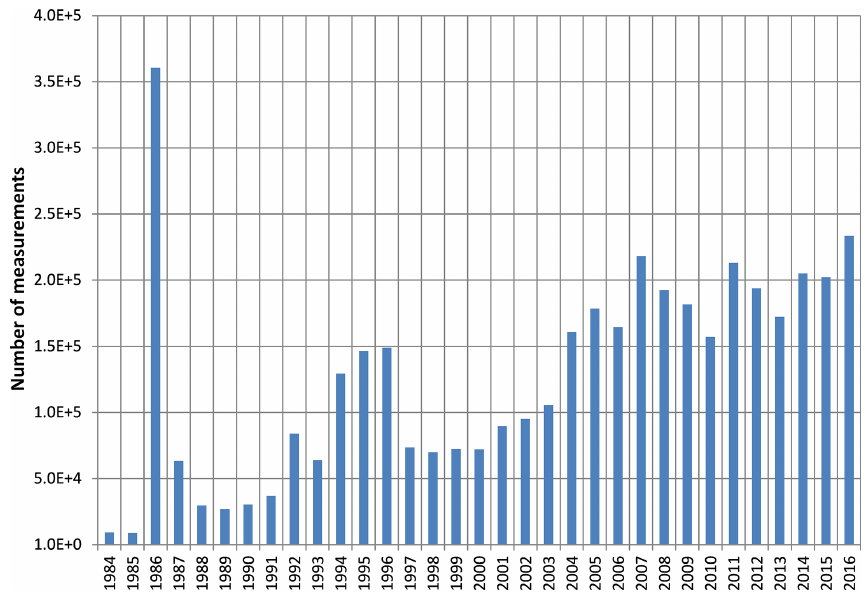
Figure 2. Number of single measurements stored in REMdb.